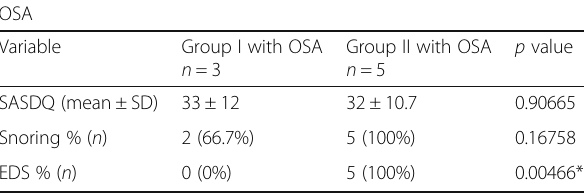
Table 5 Comparison between sleep related clinical data among patients with OSA in both groups